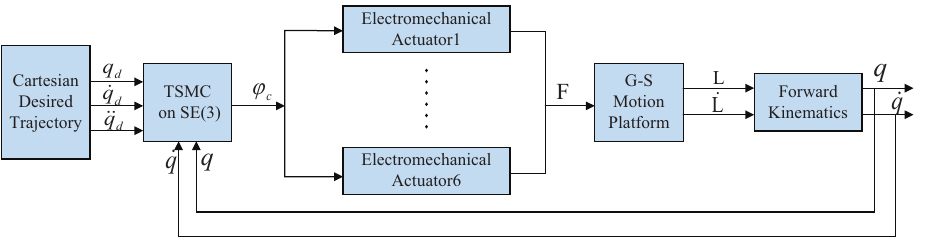
Figure 5. The control framework of TSMC on SE(3) for G-S motion systems.